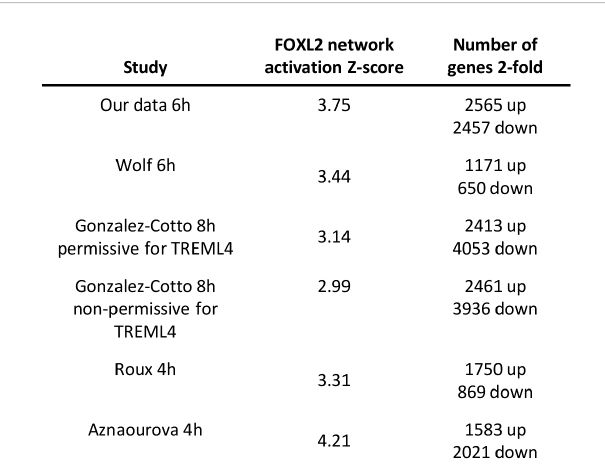
FIGURE 8 FOX protein network is induced by LPS in neutrophils in response to other in fl ammatory signals. Lists of other datasets of human neutrophils stimulated with various human in fl ammatory signals. Their associated FOX network activation Z-scores and number of 2-fold regulated genes are shown as well.